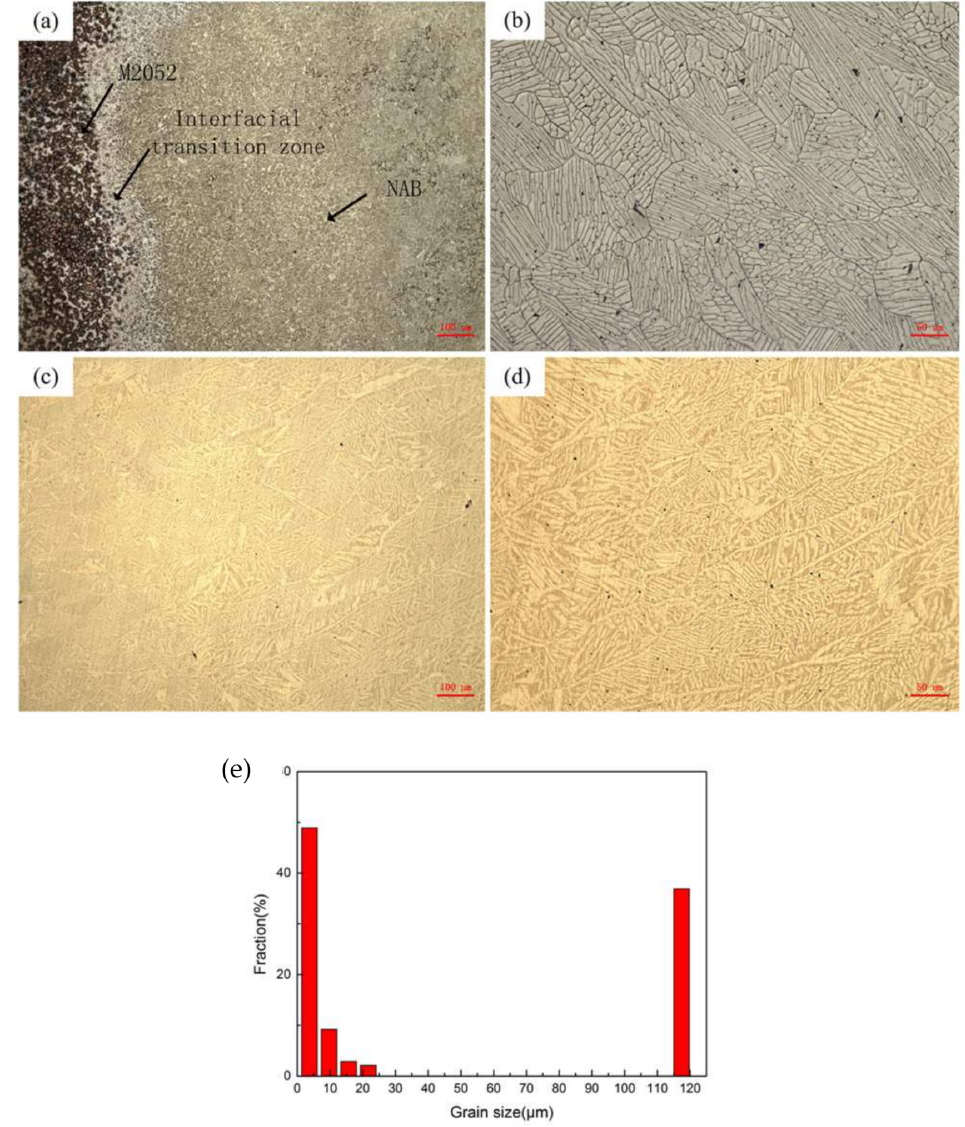
Figure 4. Microstructures of ( a ) M2052–NAB gradient alloy, ( b ) transition zone, ( c ) NAB alloy, and ( d ) NAB alloy surface pore defects, ( e ) Grain size distribution of M2052–NAB alloy. As shown by the XRD pattern (Figure 5), the crystal structure of the as-deposited NAB alloy is dominated by α phase, the Miller indices of characteristic peaks are (111), (200), (220), (311), and the diffraction peak of K phase (220) appears at 44 ◦ . The β ’ phase and the α phase are difficult to distinguish. According to the Miller index, the M2052 alloy mainly exhibited diffraction peaks of the γ -MnCu phase [40]: no diffraction